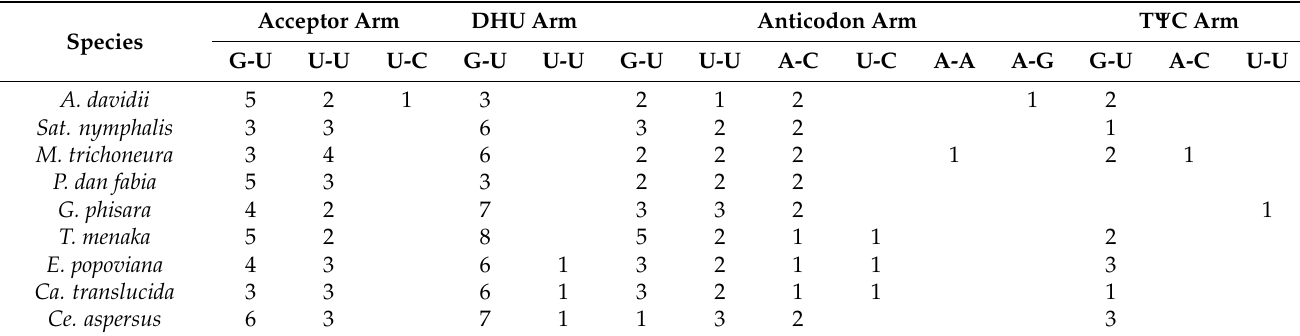
Table 5. Mismatch among the tRNAs of the nine